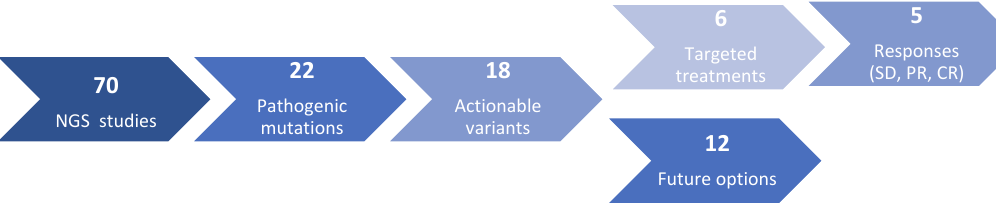
Figure 3. Workflow diagram showing the next-generation sequencing (NGS) process and targeted treatments drawn from the study.